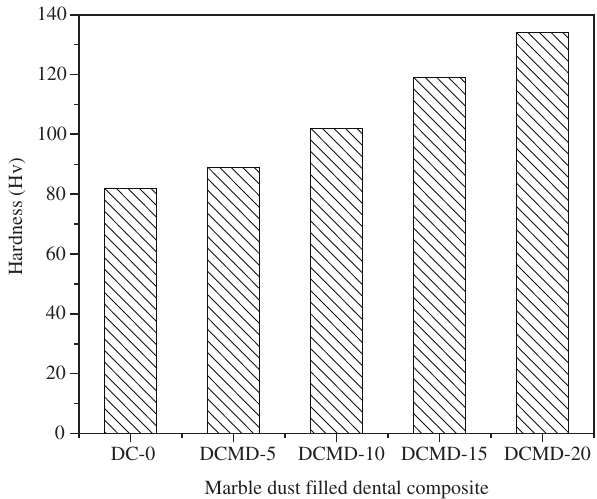
Figure 3: Effect of Vickers hardness on the marble dust-filled dental composite.